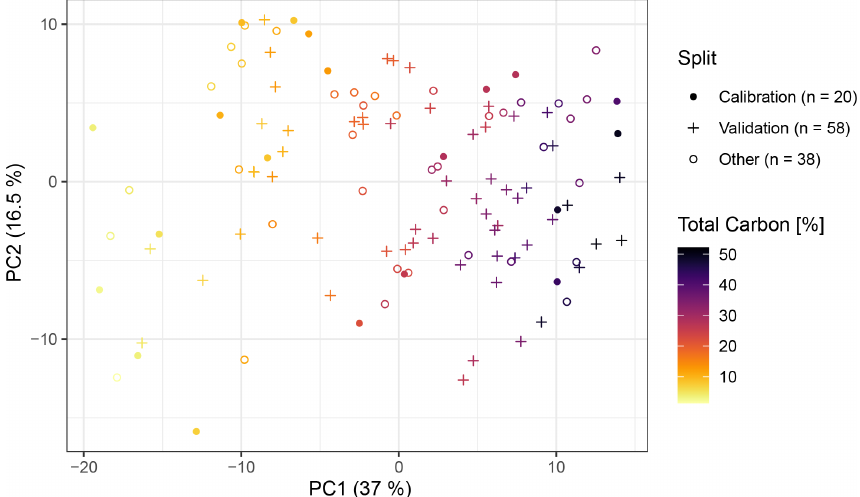
Figure 4. PC1 vs. PC2, computed via scaled and centered PCA, of the preprocessed local HAFL soil spectra ( n = 116) colored by total carbon content (percent). The axes labels show the relative amount of variance explained (percent) in parentheses. In this example, n = 20 representative samples were selected using the KS algorithm for calibrating a local